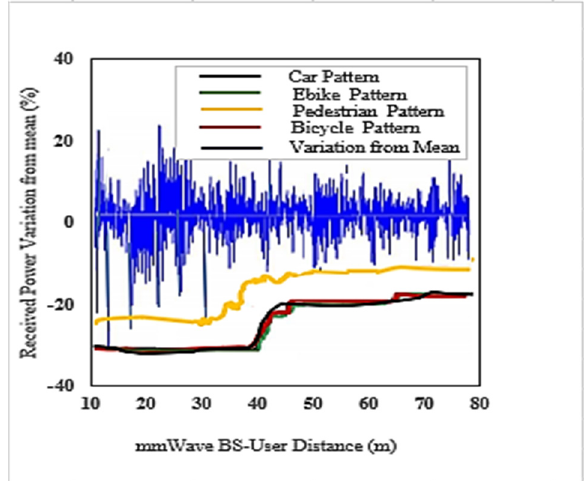
Figure 9. The actual average received power pattern variation at the UE as a percentage about the mean value after 200 episodes in the proposed JMLS–DDPG HO scheme .